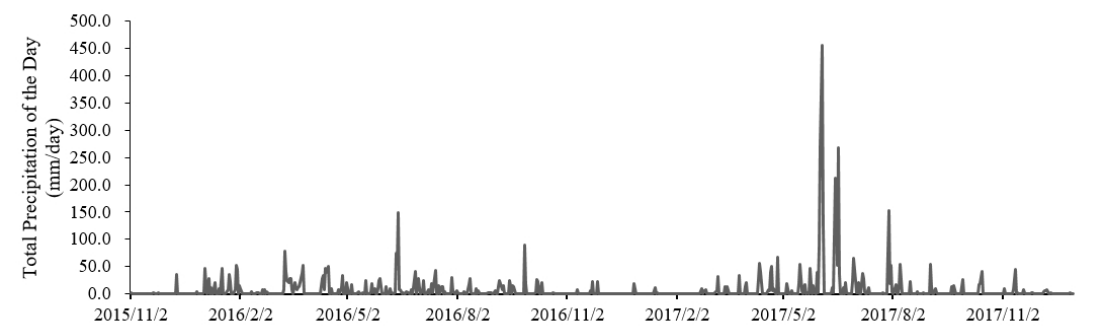
Figure 6. Huisun Forest Park precipitation data (2015/11/2–2017/12/31).